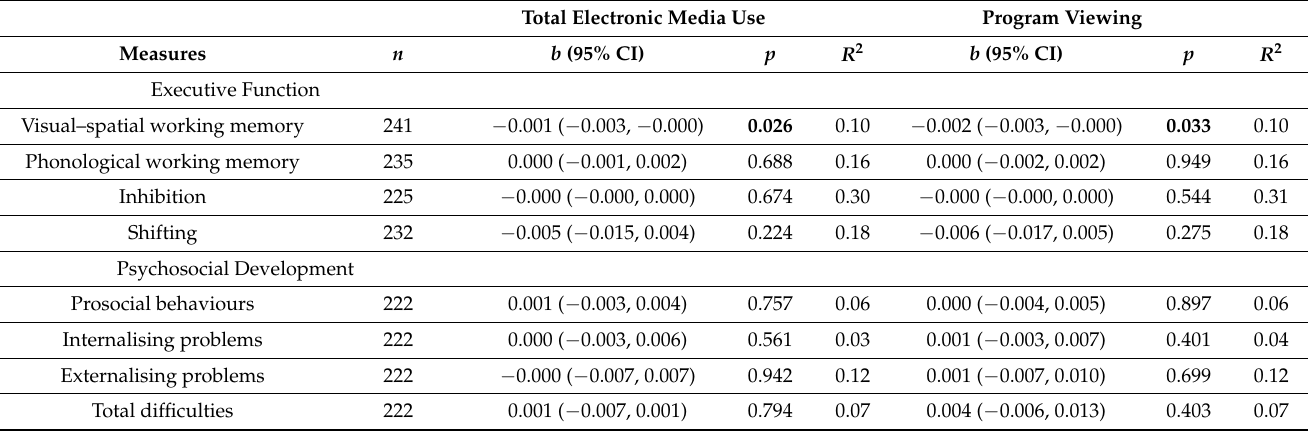
Table 2. Unstandardized beta coefficients and 95% confidence intervals for the associations of media use and program viewing with executive functions and psychosocial health